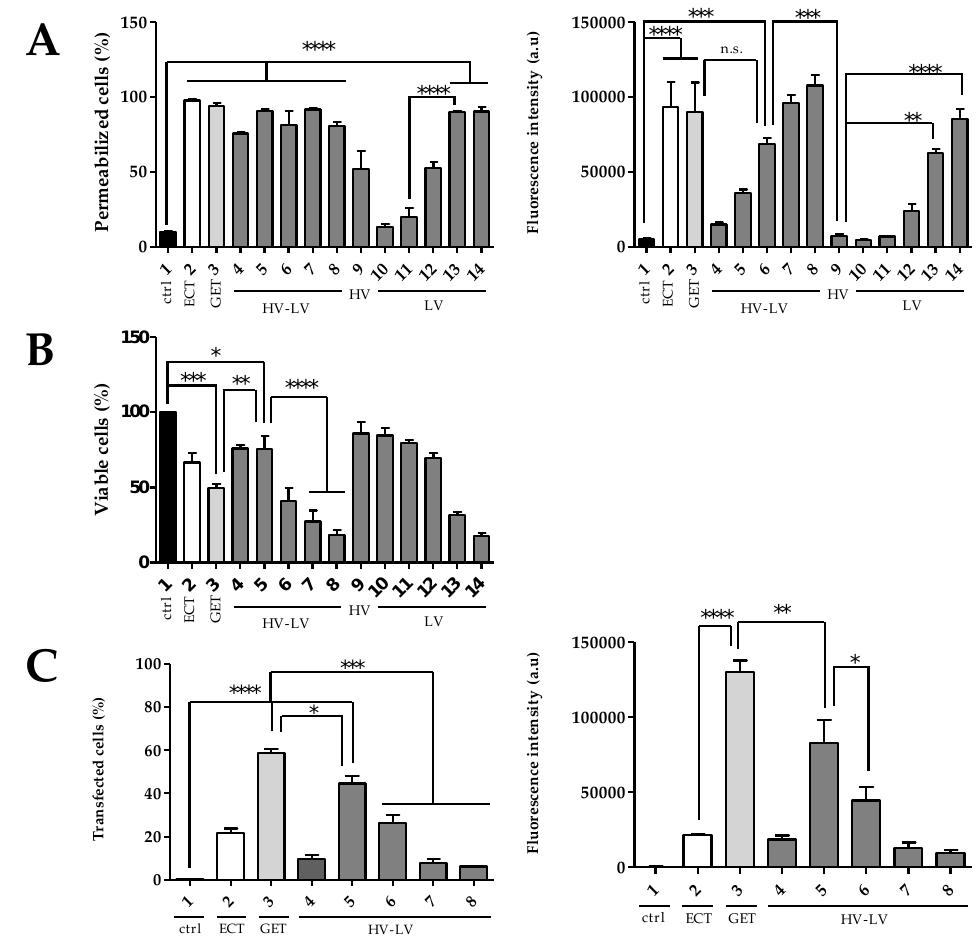
Figure 4. Effect of HV-LV pulse parameters on HCT-116 cells as function of field intensity. ( A ) Per- centages of permeabilization and associated fluorescence intensity, ( B ) cells viability, ( C ) percentages of transfected cells and associated fluorescence intensity. White histograms: cells treated under ECT pulse protocol (8 pulses of 100 µ s at 1 Hz), Light gray histograms: cells treated under GET pulse protocol (10 pulses of 5 ms at 1 Hz) and dark gray histograms: cells treated under HV-LV (HV constant (100 µ s at 1 kV/cm) and LV variant (500 to 100 ms at 0.1 to 0.5 kV/cm)). Cells were incubated with PI 50 µ M for electropermeabilization ( A ) and plasmid-encoding tdTomato 40 µ g/mL for gene electrotransfer ( C ). N = 3 independent experiments. One-way ANOVA test was performed. **** p < 0.0001, *** p < 0.001, ** p < 0.01, * p < 0.05.